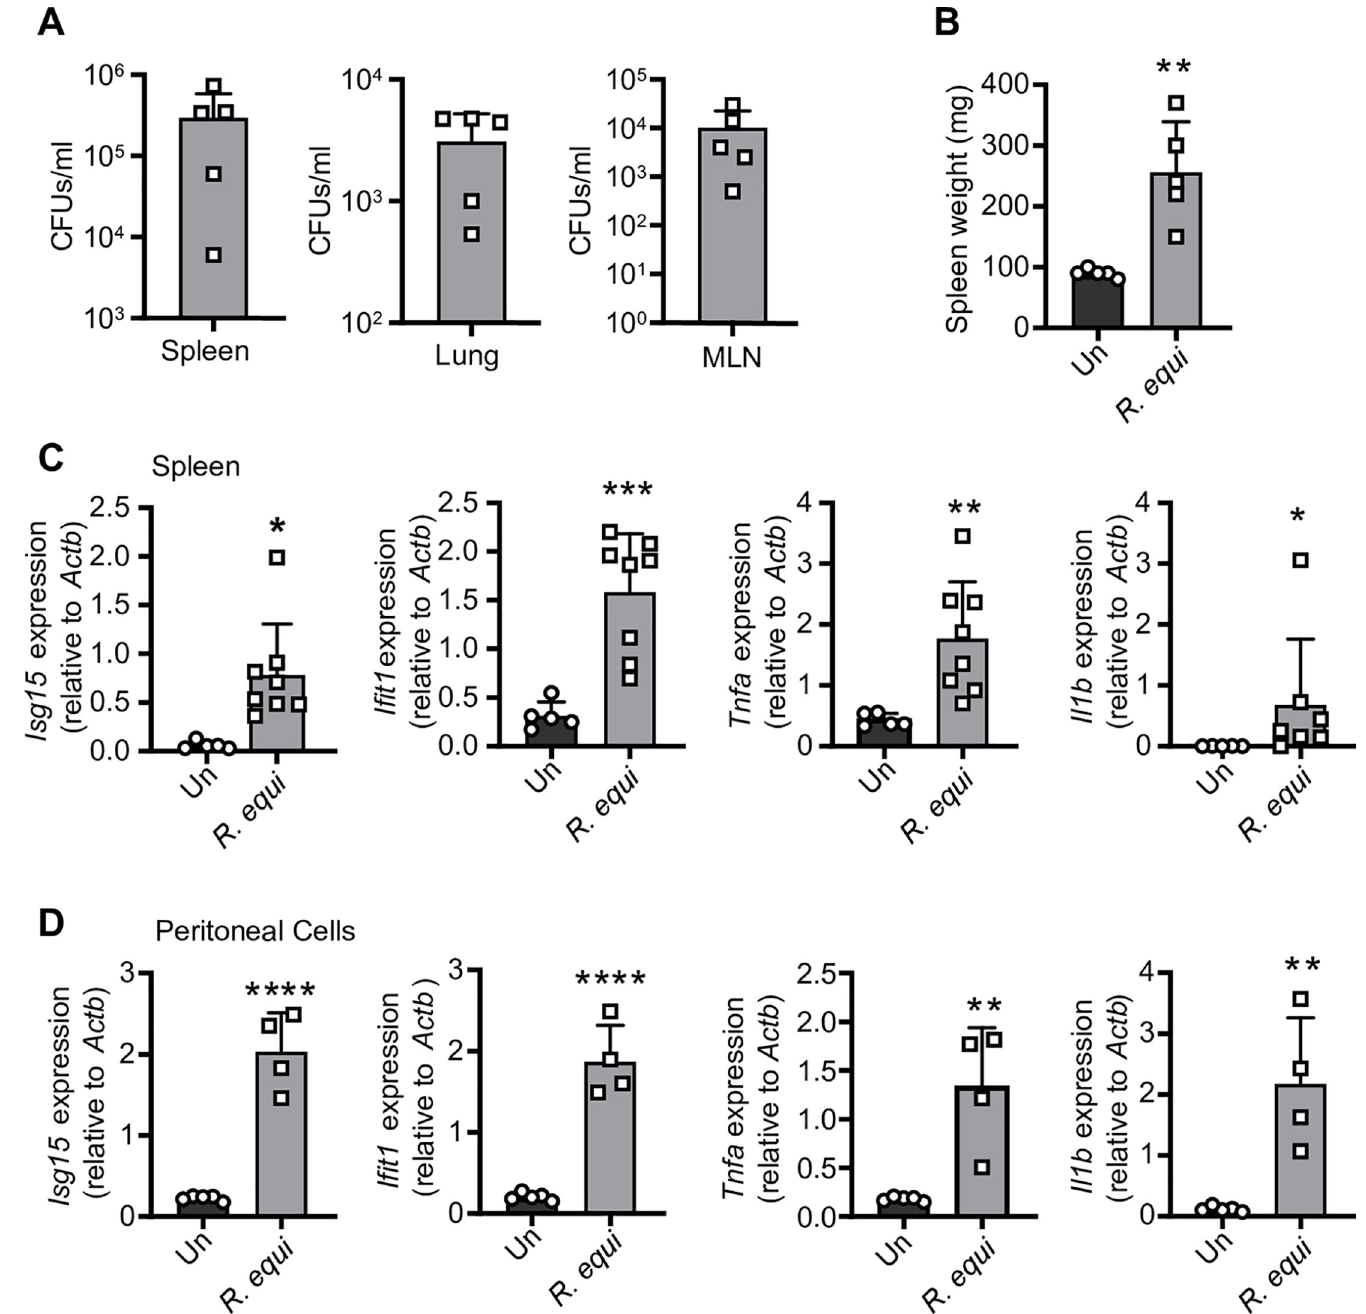
Fig 7. R . equi induces both a pro-inflammatory and type I IFN expression program in a mouse model of infection. (A) CFUs/gram of the spleen, lung and mesenteric lymph nodes of mice 5d post-infection. Each square represents an individual mouse. (B) Spleen weight in mg of mice 5d post R . equi infection. (C) RT-qPCR of Isg15 , Ifit1 , Tnfa and Il1b in the spleen of mice uninfected or infected with R . equi . (D) As in (C) but peritoneal cells. Mouse RT-qPCRs represent 5 biological replicates ± SD. For all experiments in this study, statistical significance was determined using Mann-Whitney test. � p < 0.05, �� p < 0.01, ��� p < 0.001, ���� p < 0.0001, ns = not